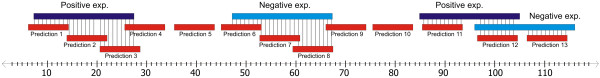
Strategy employed to assess the predictors’ performance. The scale bar represents the sequence of a theoretical protein of 120 amino acids. Dark blue rectangles represent one single epitope or a consensus of overlapping epitopes that were experimentally validated according to IEDB (Positive exp.); light blue rectangles represent one single non-immunogenic region or a consensus of overlapping non-immunogenic regions that were experimentally validated according to IEDB (Negative exp.); red rectangles represent the predicted epitopes from evaluated algorithms. For B cell prediction the predicted epitopes were considered true positive if they aligned with minimum coverage of 50% and 100% of identity with a Positive Exp. Region; for CD8+ T cell prediction the predicted epitopes were considered true positive if they aligned with minimum coverage of 87% and 100% of identity with a Positive Exp. region (Prediction 1, Prediction 2, Prediction 3 and Prediction 11). For B cell prediction the predicted epitopes were considered false positive if they aligned with minimum coverage of 50% and 100% of identity with a Negative Exp. Region; for CD8+ T cell prediction the predicted epitopes were considered false positive if they aligned with minimum coverage of 87% and 100% of identity with a Negative Exp. region (Prediction 6, Prediction 7, Prediction 8 and Prediction 13). Predictions were not considered during the analysis if they did not align with the parameters cited above (Prediction 4, Prediction 5, Prediction 9 and Prediction 10) or if they aligned with both Positive exp. and Negative exp. (Prediction 12).